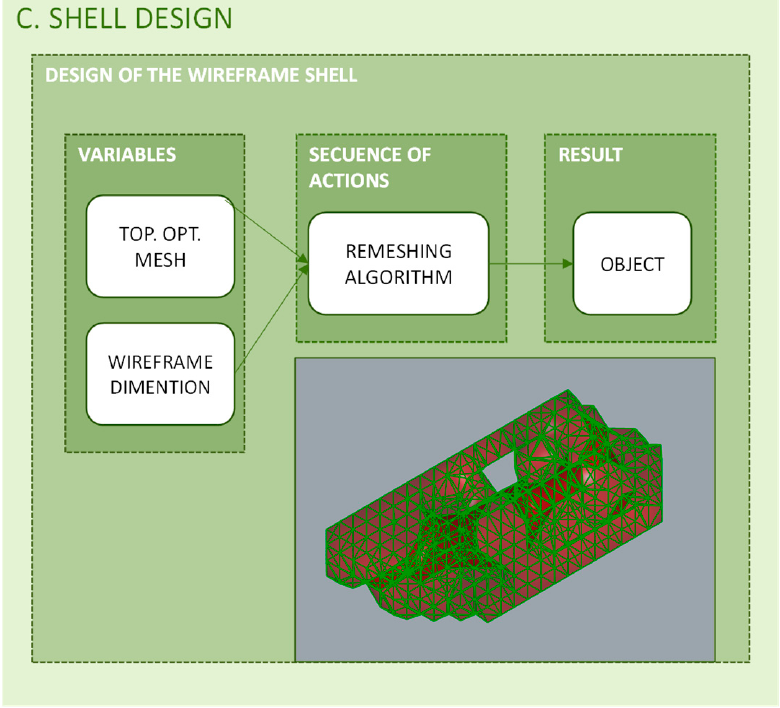
Polymers 2020 , 12 , x FOR PEER REVIEW Figure 10. Programming structure for the wireframe shell design. Figure 10. Programming structure for the wireframe shell design.